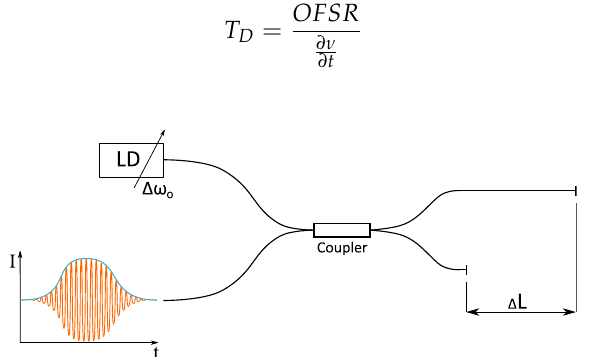
Figure 1. The proposed system utilizes an unbalanced fiber interferometer and Optical Frequency Sweep (OFS) narrowband laser